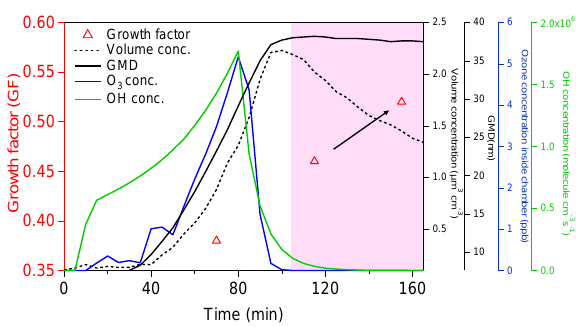
Fig. 6. Evolution of volatility of 50 nm SOA determined at temperature 150 ˚ C formed in P1023, as an example of the OH-dominated chemistry in this study. Blue curve shows the measured ozone concentration inside the chamber; Solid black curve is for Geometric Mean Diameter (GMD) from FMPS measurement; Green curve is the simulated OH concentration inside the chamber from the model prediction; Dashed black curve is for the measured aerosol volume concentration inside the chamber. No oxidants were observed in the pink bar area.